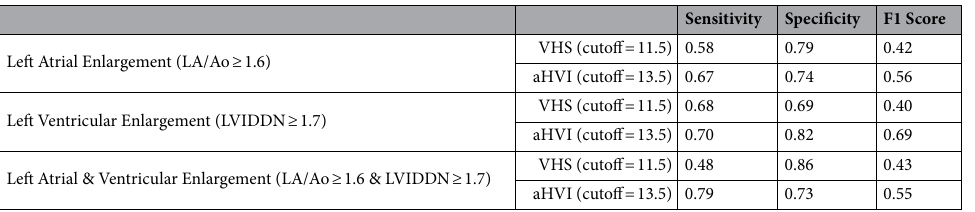
Sensitivity Specificity F1 Score